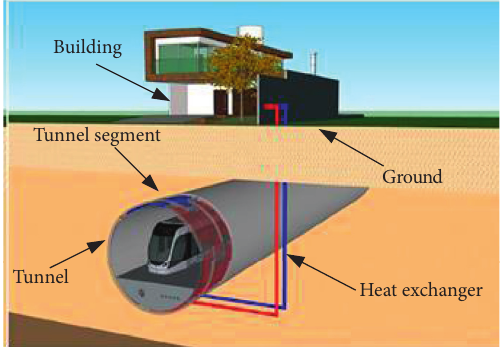
Figure 1: Energy-tunnel